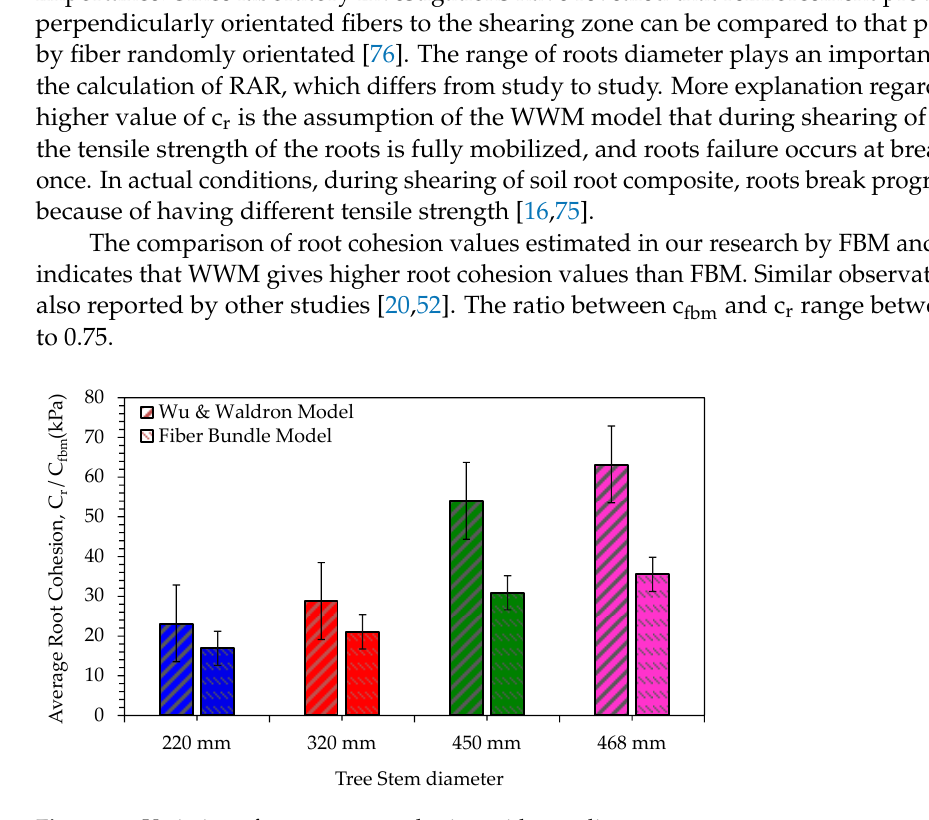
Figure 13. Variation of average root cohesion with tree diameter.